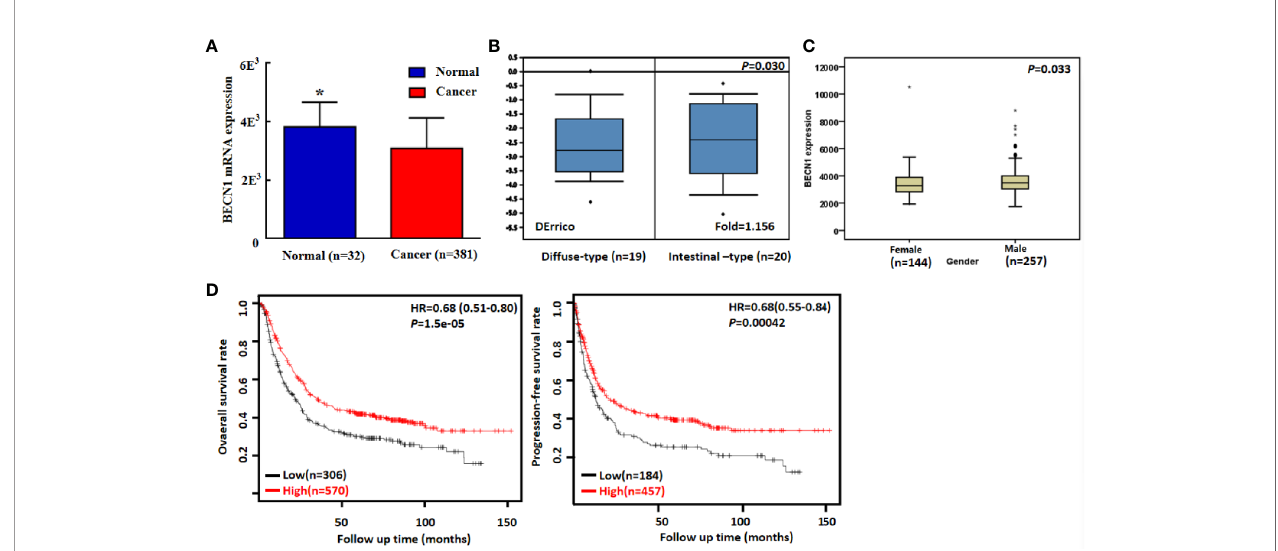
FIGURE 6 | Becn1 mRNA expression in gastric carcinogenesis and subsequent progression. A lower Becn1 mRNA expression was detectable in gastric cancer than that in normal gastric mucosa according TCGA data [ (A) , P < 0.05]. There was Becn1 overexpression in intestinal-type than diffuse-type carcinoma according to DErrico ’ s database [ (B) , P < 0.05]. TCGA database showed a higher Becn1 mRNA expression in male than female patients with gastric cancer [ (C) , P < 0.05]. According to the data from Kaplan-Meier plotter, Becn1 mRNA expression was positively related to both overall and progression-free survival rates of the patients with gastric cancer [ (D) , P < 0.05]. HR, hazard ratio. *P < 0.05, compared with the cancer.